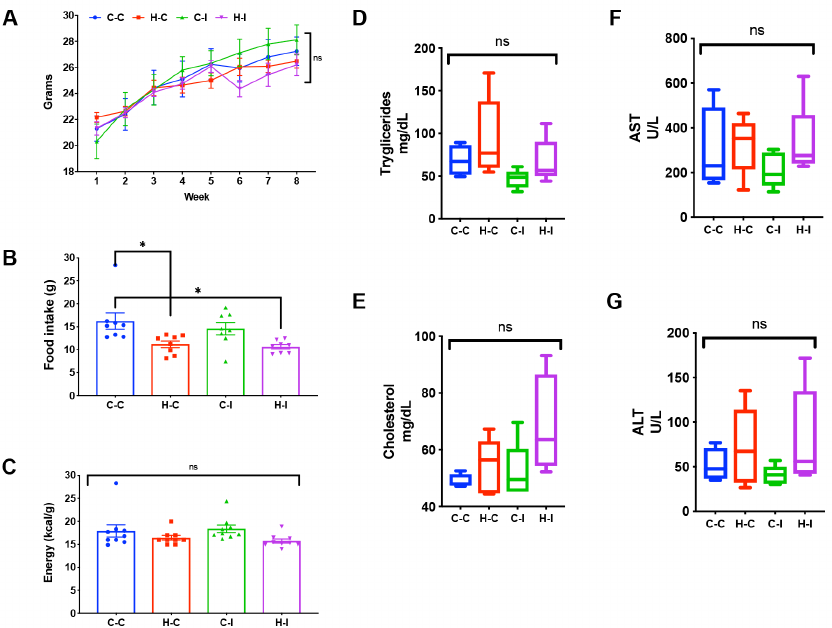
Figure 1. ( A ) Time-lapse of body weight gain in the different mice groups; ( B , C ) food and energy intake, respectively, at the end of the four weeks period of inulin treatment; Quantitation of serum triglycerides ( D ) and cholesterol ( E ) in mice of the indicated groups after four weeks of treatment. ( F , G ) Plots showing AST and ALT serum levels, in the four mice groups after the diet time period. Lines and bars in ( A – C ) indicate the mean ± SEM for each group, while boxplots in ( D – G ) indicate the median ± SD for each case. * p < 0.05; One-way ANOVA and Tukey test; ns, non-significant.